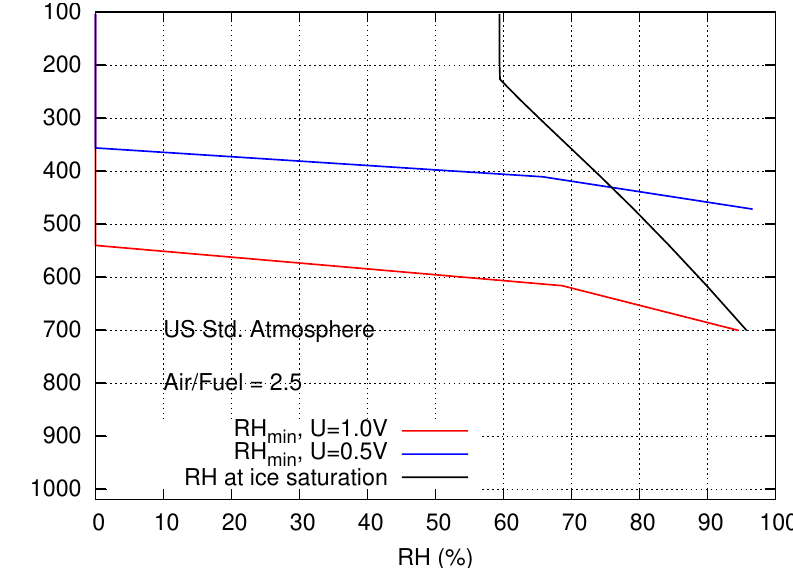
Figure 3. Profiles of the relative humidity required for contrail formation for the same temperature profile as in Figure 2 and for fuel cells with voltages of 1V (red) and 0.5V (blue). The black line represents the relative humidity at which ice saturation is reached. This is a function of temperature only and is not defined for temperatures above the freezing point of